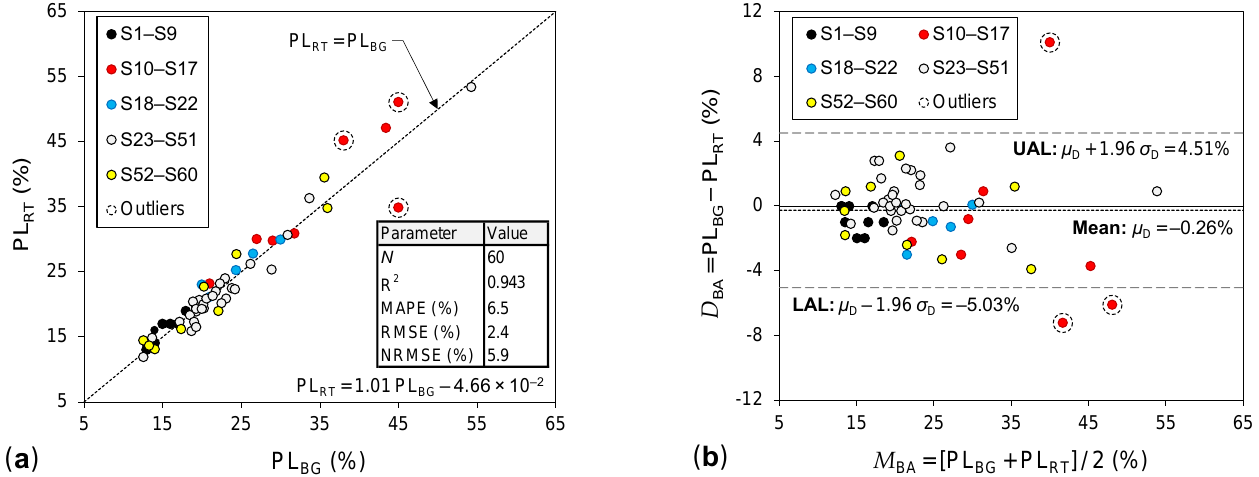
Figure 3. Comparison of PL RT and PL BG for the compiled database of N = 60 fine-grained soils: ( a ) PL RT –PL BG correlation plot; and ( b ) PL BG –PL RT Bland–Altman plot. Note: LAL and UAL denote lower and upper agreement limits, respectively.